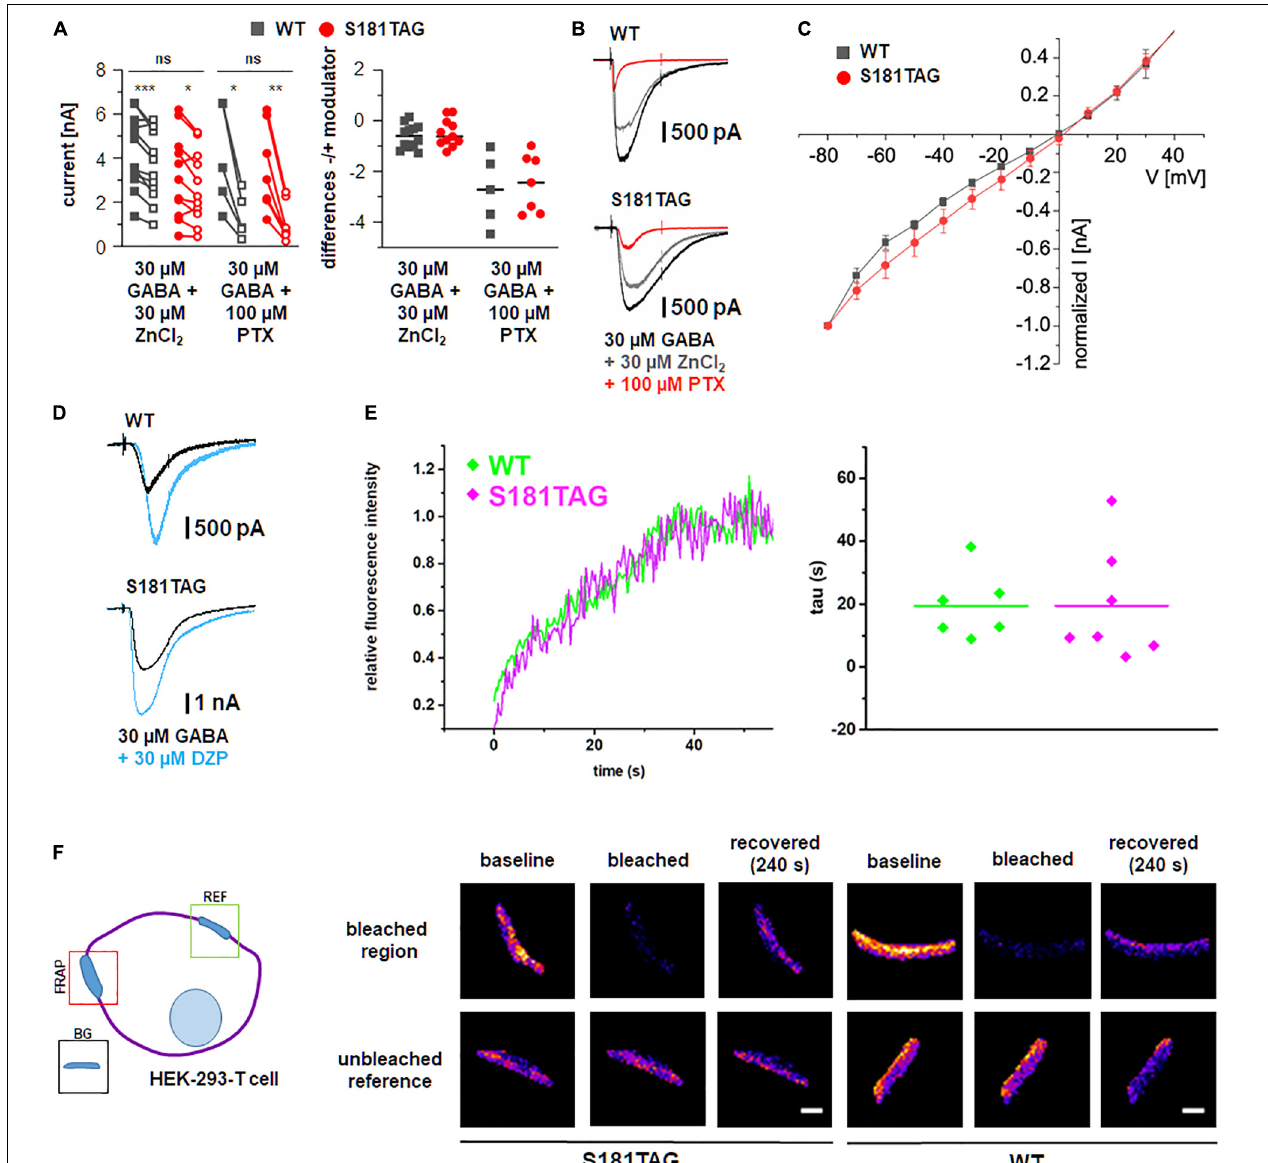
FIGURE 3 | Physiological channel function and diffusion behavior of surface GCE modified GABA-A receptors. (A) Validation of physiological function of modified GABA-A receptors by patch-clamp electrophysiology of HEK-293 cells. Left: Amplitude of GABA-evoked currents elicited from WT (gray) and click receptors (red) in control conditions (filled symbol) and upon the application of Zn 2 + or picrotoxinin (PTX, open symbol). Each pair of symbols represents one patched cell. The number of recorded cells varied between 5 and 12 ( n = 5–12). Significance level * p ≤ 0.05, ** p ≤ 0.01, and *** p ≤ 0.001. Right: Differences between each current pair shown left. (B) Representative current traces for data shown in (A) . Black traces: 30 µ M GABA; gray traces: 30 µ M GABA + 30 µ M ZnCl 2 ; red traces: 30 µ M GABA + 100 µ M (PTX). (C) Comparison of IV curves of WT and click mutant S181TAG applying voltage steps of 10 mV starting at –80 mV. S181TAG modified α 2 subunits coexpressed with β 1 and γ 2 subunits show similar I – V curves compared to WT receptors. (D) Representative current traces of diazepam (DZP) modulation from WT and click receptors. Black traces: 3 µ M GABA (WT), 30 µ M GABA (S181TAG); blue traces: 3 µ M GABA + 3 µ M DZP (WT), 30 µ M GABA + 30 µ M DZP (S181TAG). (E) Diffusion behavior of click-mutant S181TAG vs WT in HEK-293-T cell membranes. Impact of amber mutation S181TAG on GABA-A receptor diffusion determined by FRAP experiments. HEK-293-T cells expressing WT (green) and click S181TAG (magenta) GABA-A receptor α 2 subunits labeled with anti-HA AF488. Both constructs show similar fluorescence recovery after photo bleaching of selected regions on equatorial membrane. Right: Evaluation of time constant tau (s), defined as the diffusion time necessary to reach 50% of the fluorescence intensity of the recovered state, shows similar values for click-mutant and the WT (WT: 19.50 ± 4.38 vs. S181TAG: 19.51 ± 6.78, mean ± SEM; p = 0.617, Mann–Whitney U test). This might indicate that the amber mutant is not hindering the diffusion of functional GABA-A receptors. Lines denote mean and single data points are depicted. (F) Scheme for FRAP recordings. FRAP recordings taken from selected regions of interest (blue) on anti-HA immunolabeled HEK293-T cell membranes (magenta). Reference regions (REF) on cell membrane without strong photobleaching and background signal (BG) from extracellular signal entering the equation. Exemplary FRAP images of S181TAG mutant and WT labeled with anti-HA AlexaFluor 488 antibodies. Images display baseline, photobleached, and recovered signal after 240 s inside respective regions of interest for photobleached (FRAP) and reference (REF) regions. Scale bar = 1 µ m.